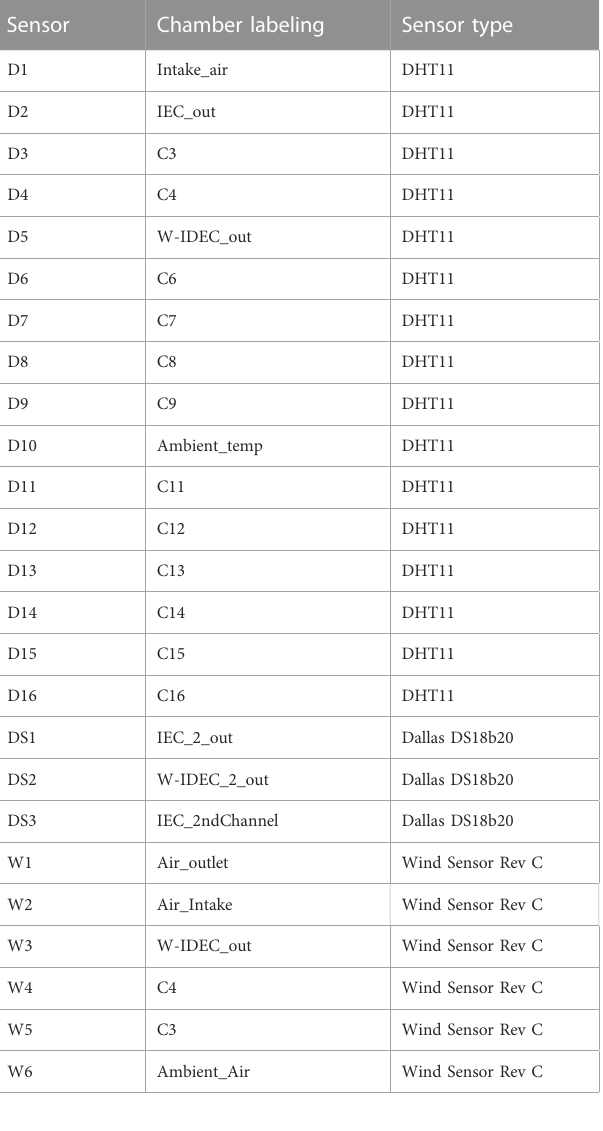
TABLE 1 Sensor ’ s location and naming of data